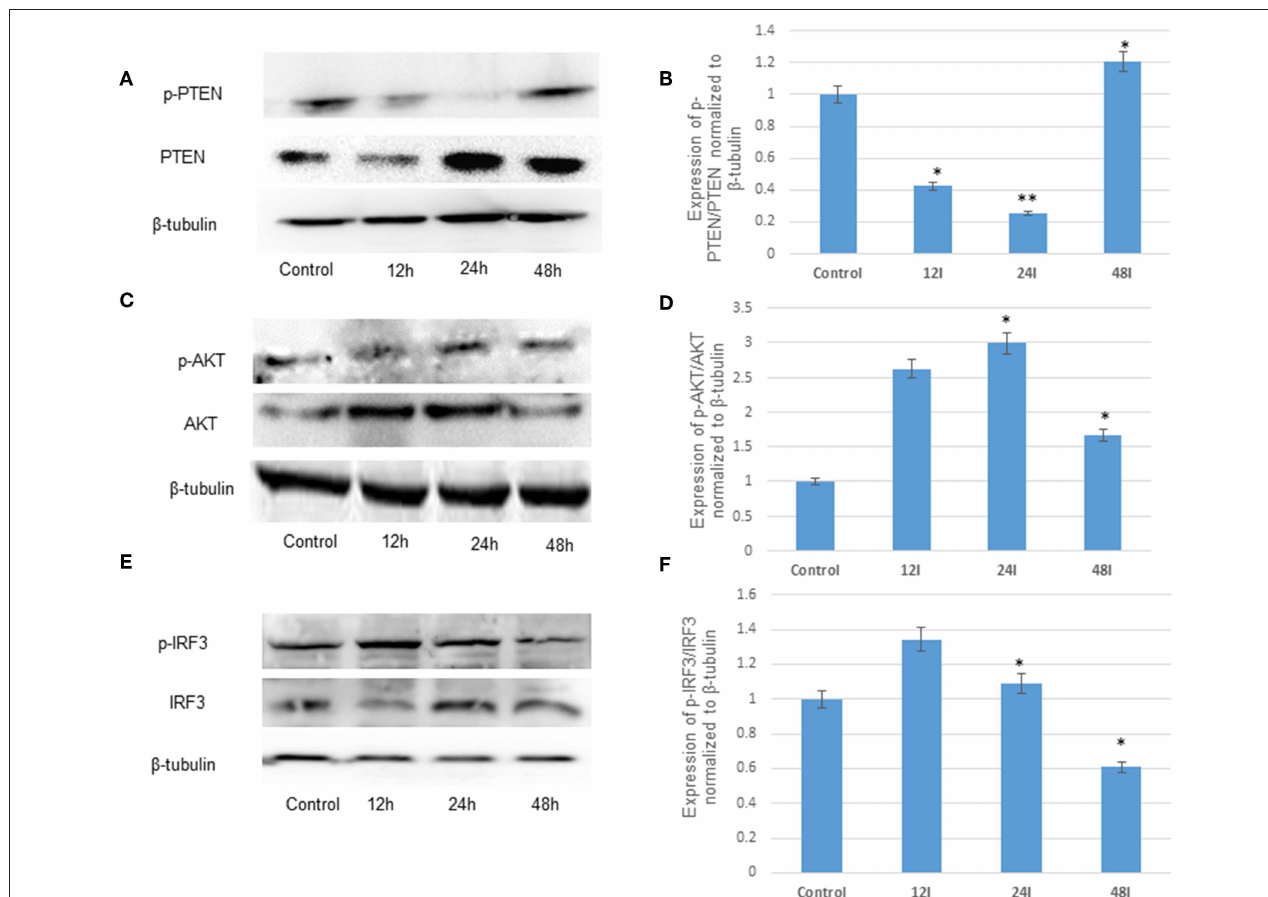
FIGURE 1 | JEV infection suppresses the negative regulator, PTEN and modulates PI3K/AKT pathway in human microglial cells. (A) Immunoblot of p-PTEN/PTEN at 12, 24, and 48h post JEV infection compared to control (B) densitometry. (C) Immunoblot of p-AKT/AKT 12, 24, and 48h post JEV infection compared to control (D) densitometry. (E) Immunoblot of p-IRF3/IRF3 12, 24, and 48h post JEV infection compared to control (F) densitometry. All experiments were performed in triplicate ( n = 3 ). The data are shown as mean ± S.E from three independent experiments. The fold change is significant where * denotes P < 0.05, ** denotes P < 0.01, *** denotes P <